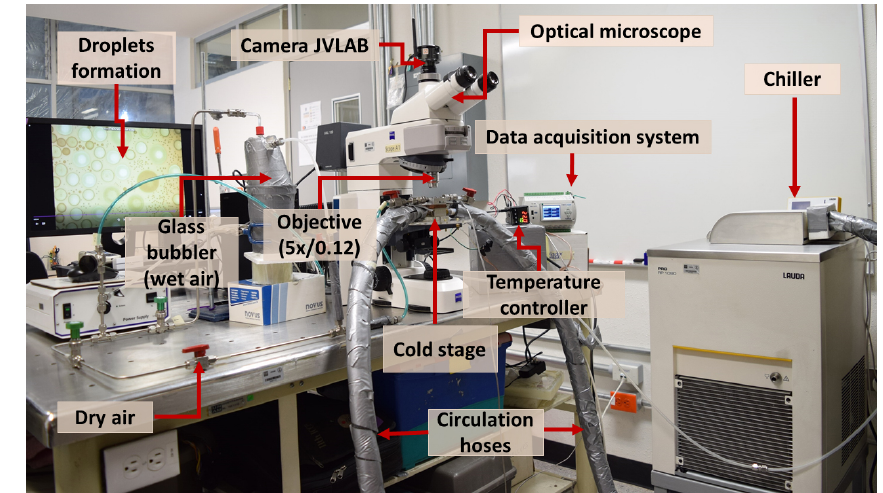
Figure 3. UNAM-DFT experimental setup with its main components. Figure S1 shows a zoom of the cold stage.